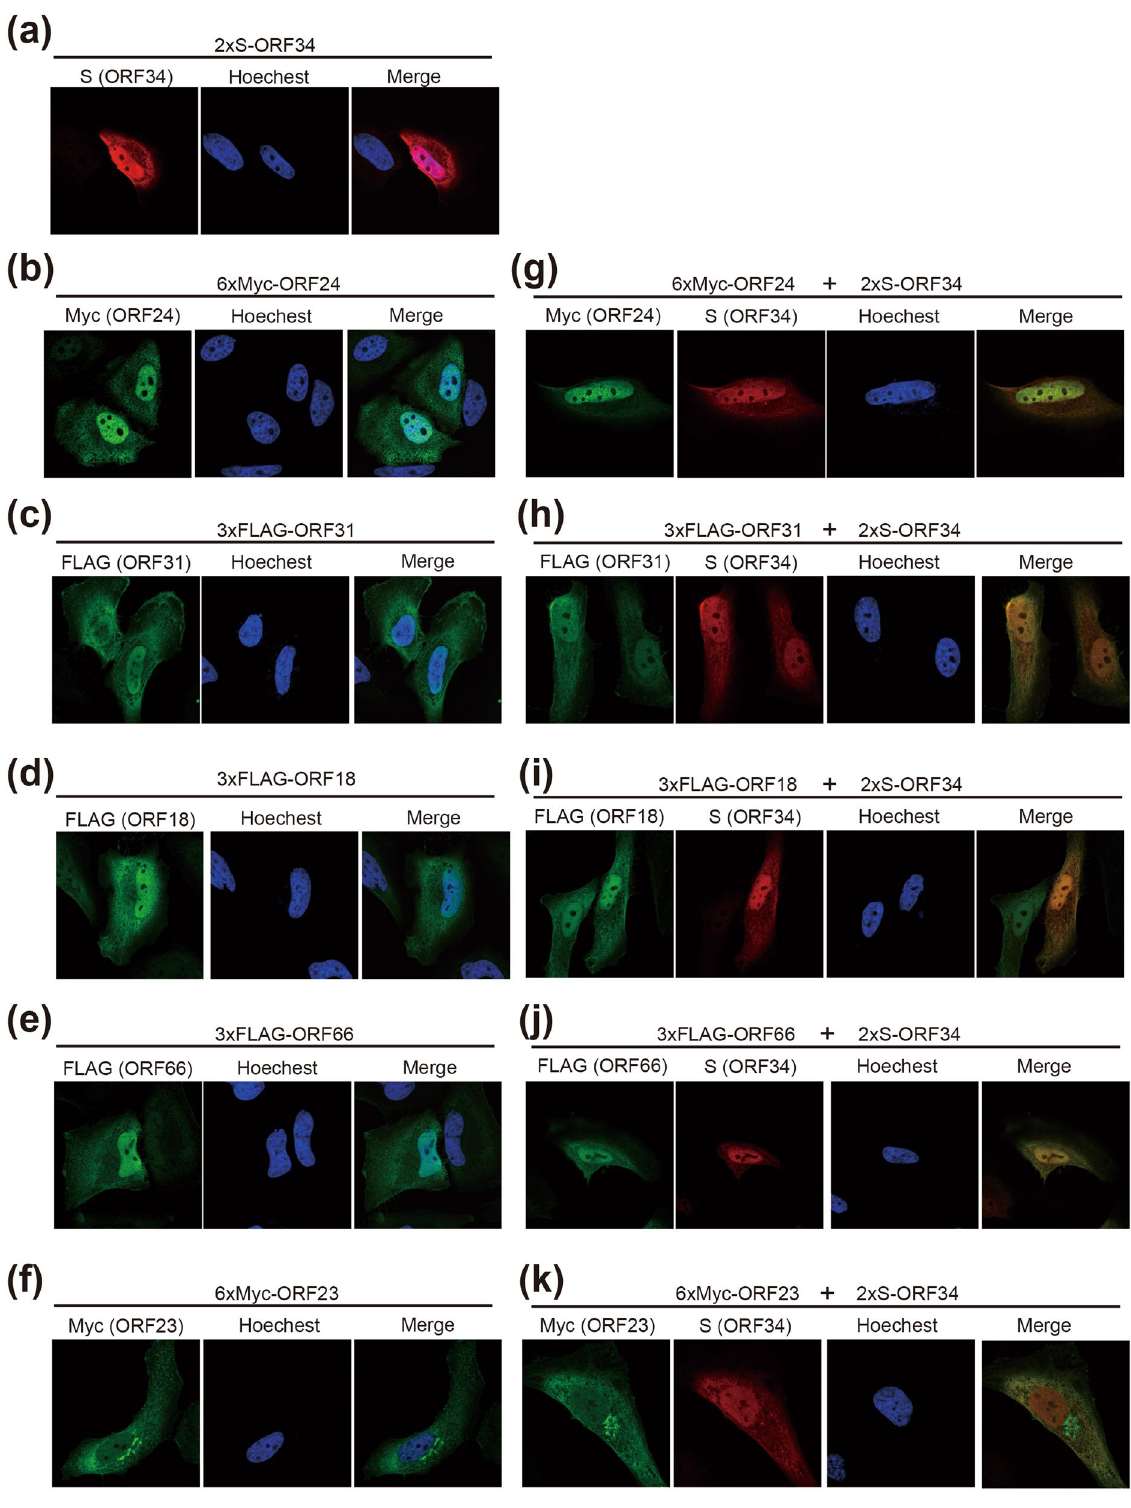
Figure 5. ORF34 colocalizes with ORF24, ORF31, ORF18, ORF23, or ORF66. HeLa cells were also transfected with 2xS-tagged ORF34 ( a ), 6xMyc-ORF24 ( b ), 3xFLAG-ORF31 ( c ), 3xFLAG-ORF18 ( d ), 3xFLAG-ORF66 ( e ), or 6xMyc-ORF23 plasmids ( f ). 2xS-tagged ORF34 plasmid was transfected alone or cotransfected with 6xMyc- ORF24 ( g ), 3xFLAG-ORF31 ( h ), 3xFLAG-ORF18 ( i ), 3xFLAG-ORF66 ( j ), or 6xMyc-ORF23 plasmid ( k ) into HeLa cells, which were then subjected to IFA. Immunofluorescent images were obtained with an inverted confocal microscope. DNA were visualized with Hoechest 33342 staining, and 2xS-tagged ORF34 and the other ORFs (3xFLAG- and 6xMyc-) represented with red and green color, respectively. “Merge” indicates overlaid images of ORF34 (red) and another ORF